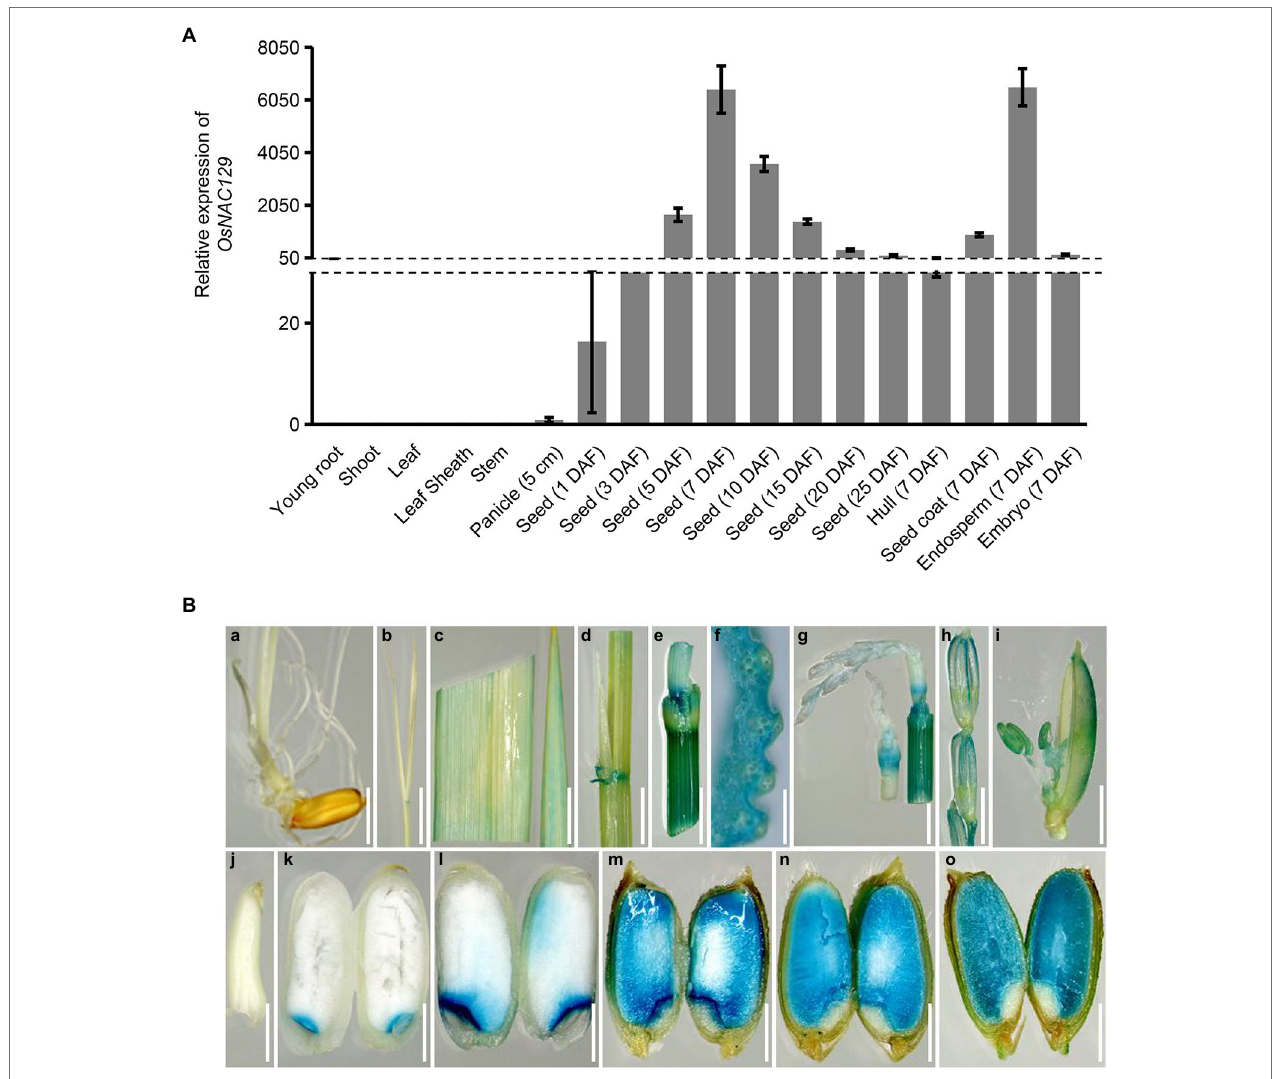
FIGURE 1 | OsNAC129 is highly expressed in immature seeds. (A) Expression profiles of OsNAC129 in “Nipponbare.” Total RNA was extracted from roots and shoots at 7 days after germination, from leaves, leaf sheathes, stems, and young panicles before flowering, and from developing seeds from 1 to 25 days after fertilization (DAF). Actin1 was used as the internal control for normalization of gene expression. Data are means ± SD of four biological replicates. (B) OsNAC129 promoter-GUS expression patterns in transgenic plants. GUS expression in root (a) and shoot (b) at 7 days after germination, flag leaf (c) , leaf sheath (d) , stem (e) , and cross section of stem (f) at heading date, younger panicle (g) , older panicle (h) , flowering spikelet (i) , and endosperm at 3 DAF (j) , 5 DAF (k) , 7 DAF (l) , 10 DAF (m) , 15 DAF (n) , and 25 DAF (o) . Scale bars (a–e, g, and h) = 5 mm; scale bar (f) = 1 mm; scale bars (i–o) = 2.5